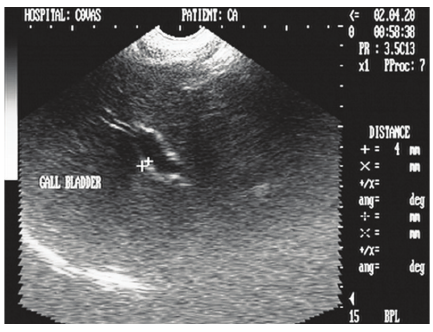
Figure 25: Two-dimensional ultrasonographic appearance in sagit- tal scan of cirrhosed liver lobe in a seven-year-old intact mixed- breed dog depicting collapsed and irregularly shaped gall bladder with echogenic and thickened (4 mm) GB wall.